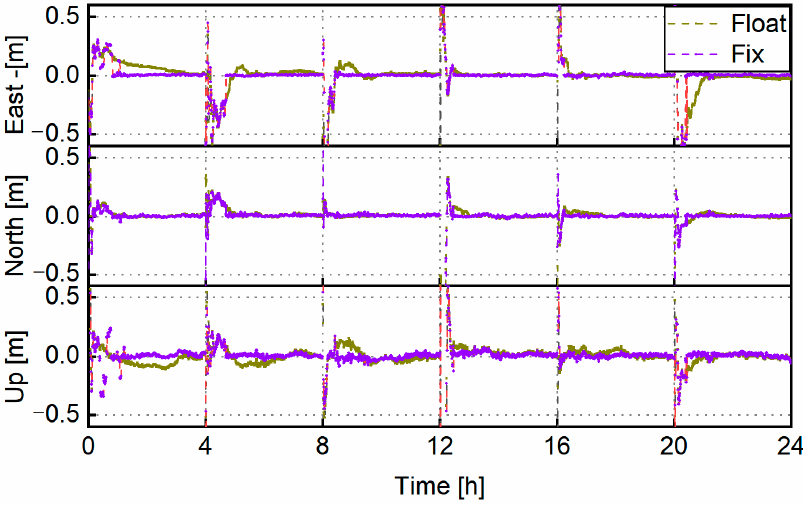
Figure 2. The positioning error at station AGGO with kinematic mode in north, east, up components.